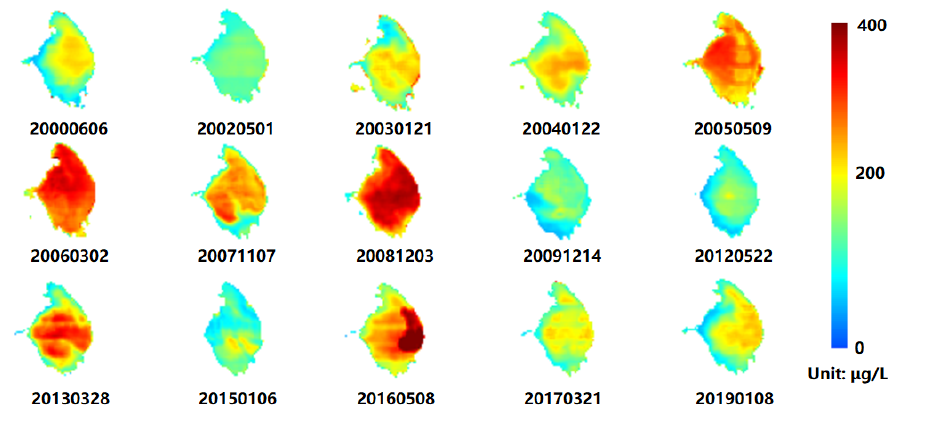
Figure 4. Spatial distributions of TP in Lake Okeechobee from 2000 to 2019.